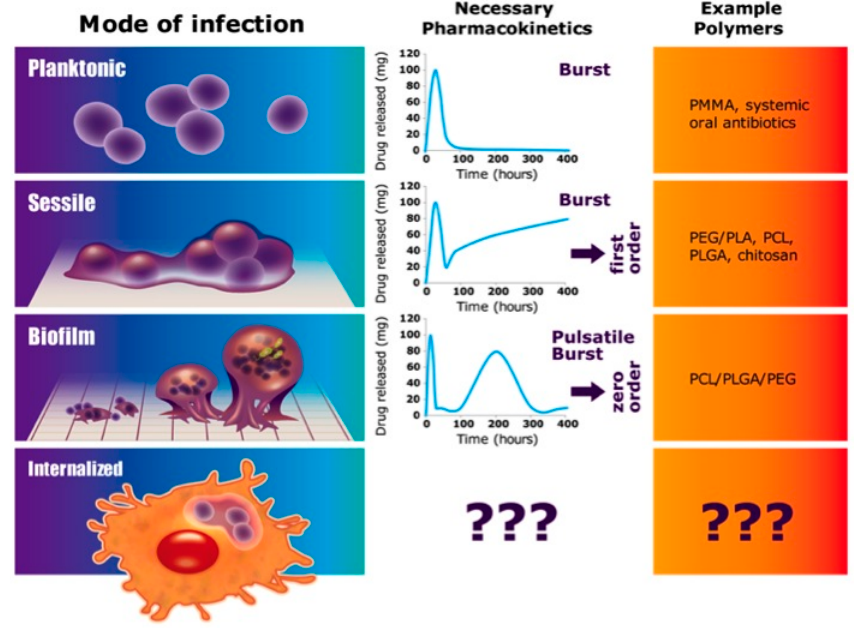
Figure 9. There are four relevant modes of infection related to total joint replacement. Planktonic bacteria-sourced infections can be combatted with simple burst release kinetics such as that provided by bone cements (i.e., Poly(methyl methacrylate)) or systemic antibiotics. After attaching to a surface, sessile bacteria are slightly more difficult to treat and typically require a first-order or zero-order sustained release after the burst. To combat biofilm resident bacteria, a pulsatile burst with zero-order kinetics are thought to be essential. Such sustained release formulations may be provided using combinations of polymers such as that described here. The most challenging orthopedic infections, recurring chronic osteomyelitis, will require distinctly new approaches with new polymer compositions (e.g., pendant-functionalized polymers, etc.).